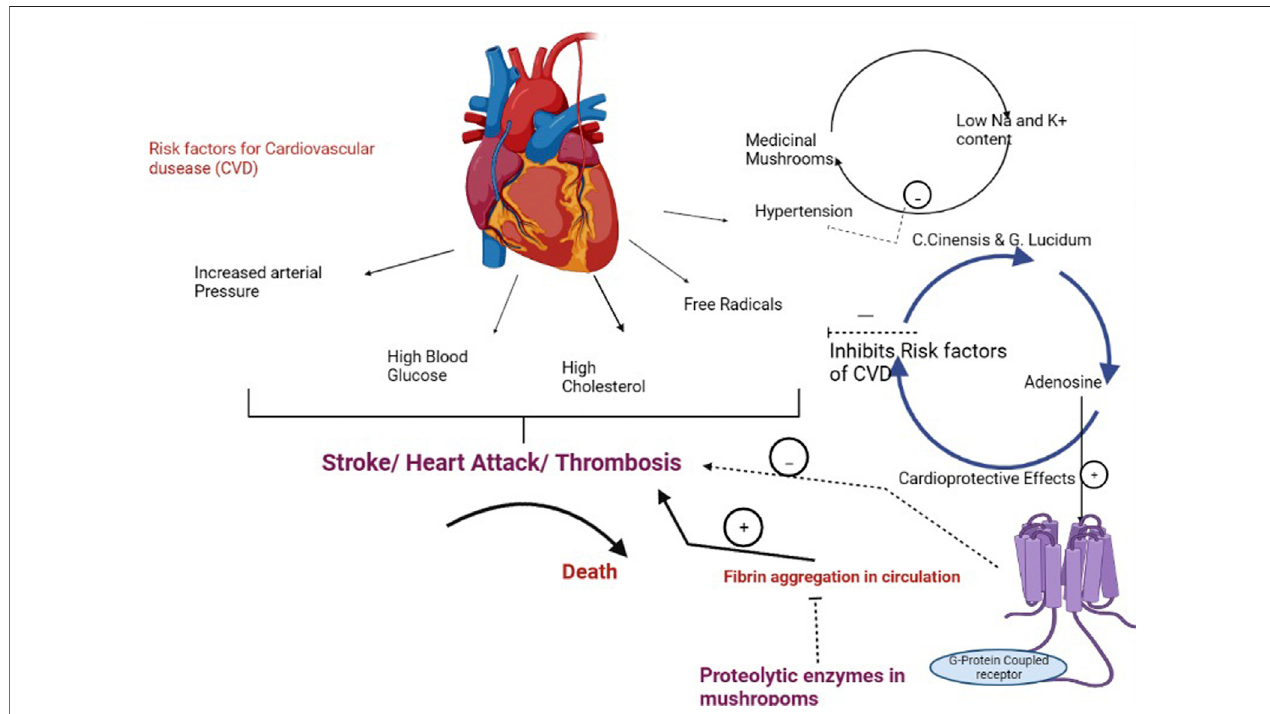
FIGURE 2 | Pathway depicting the role of medicinal mushrooms in prevention of cardiovascular diseases.